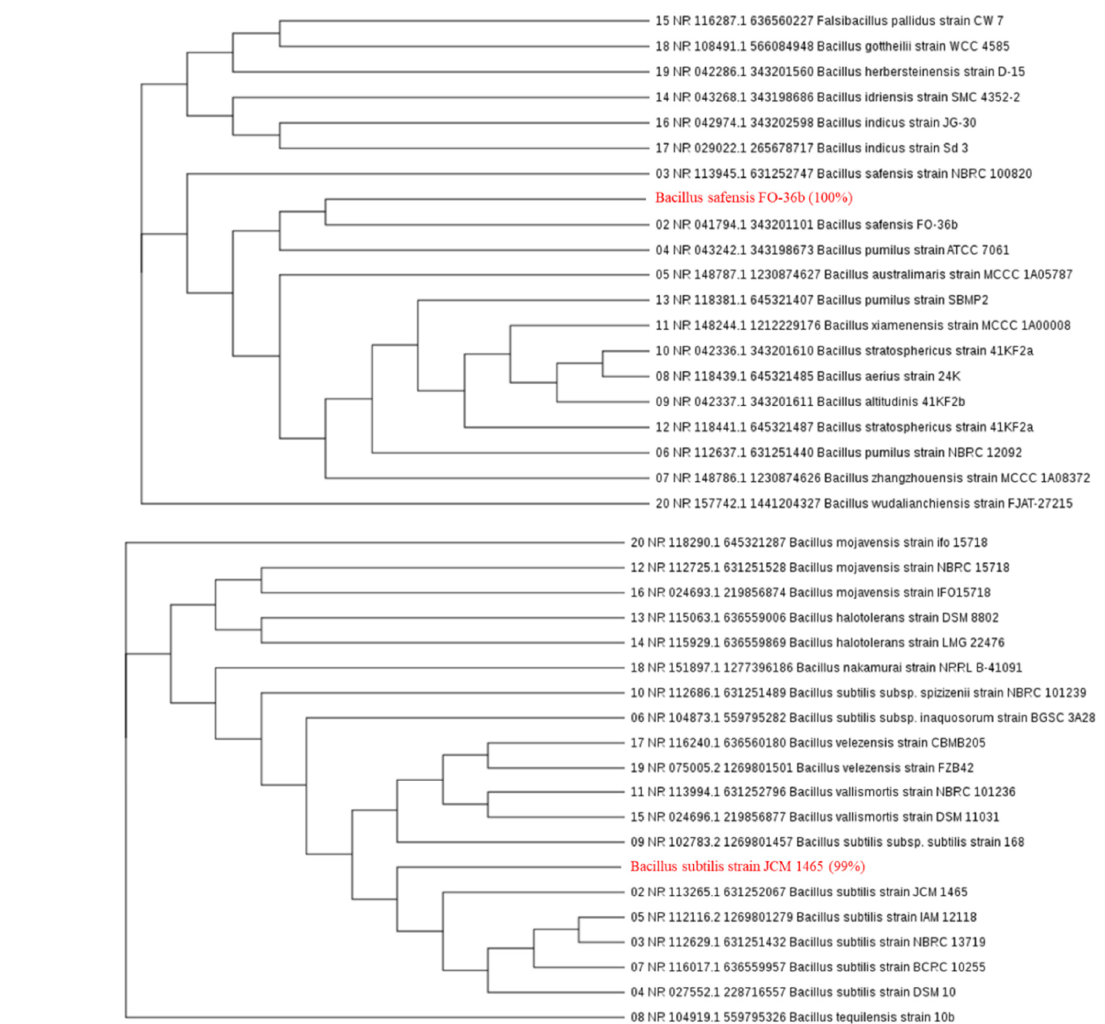
Figure 1. The phylogenetic tree derived from neighbor-joining analysis of partial 16S rRNA gene sequence: ( a ) Pseudoalteromonas mariniglutinosa , ( b ) Psychrobacter celer , ( c ) Bacillus albus , ( d ) Bacillus safensis , and ( e ) Bacillus subtilis .